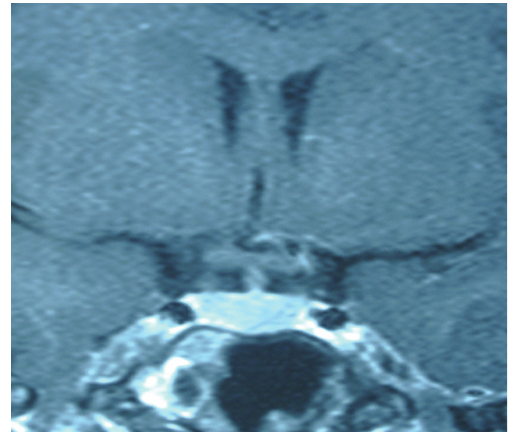
Figure 1: Magnetic resonance imaging of the sellar region of our patient: no abnormal findings.